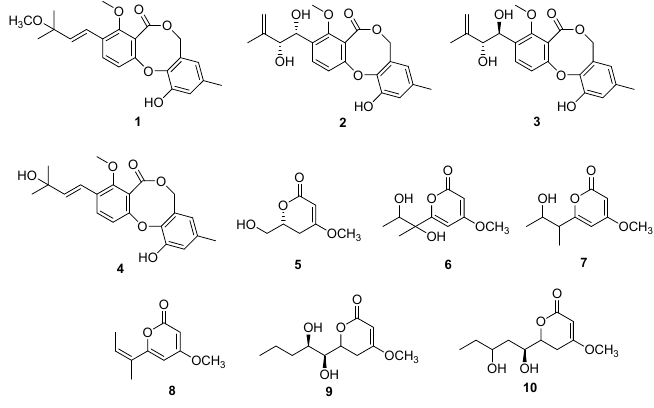
Figure 1. Structures of compounds 1 – 10.